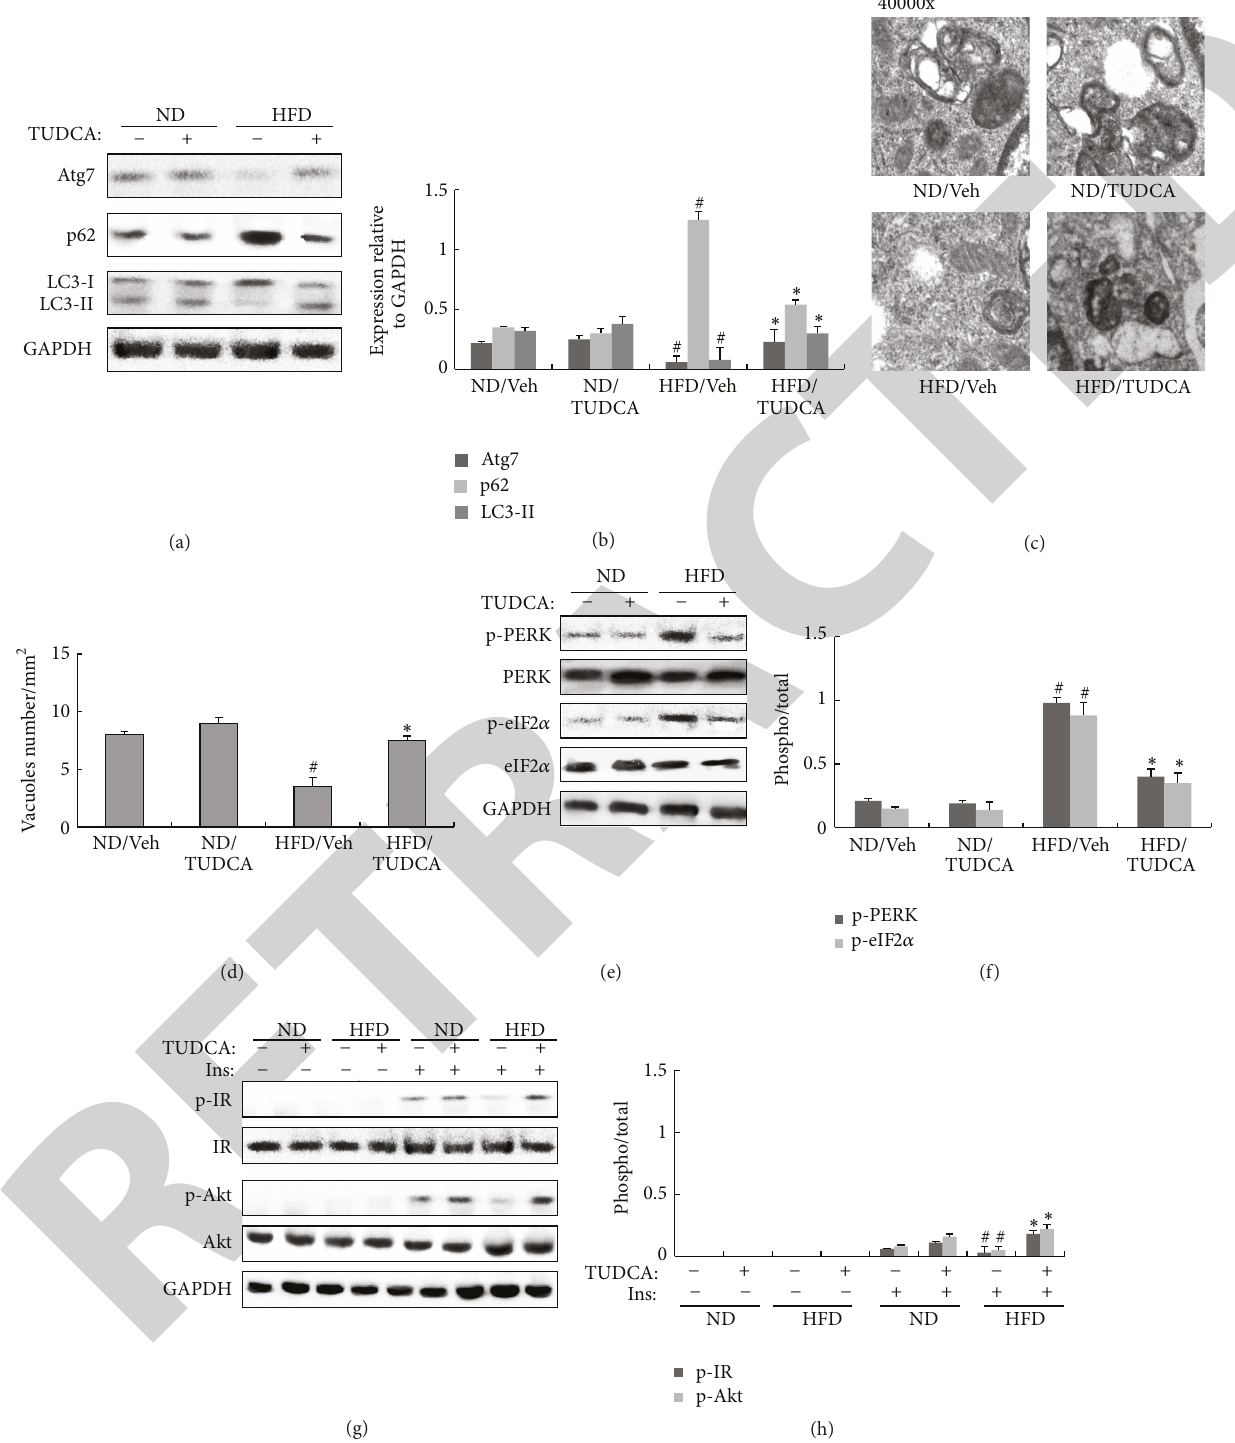
Figure 4: Effects of TUDCA on hepatic autophagic response, ER stress, and insulin signaling in the liver of obese mice. All analyses were performed in mice fed a normal diet (ND) or a high-fat diet (HFD) for 8 weeks and then injected daily with 500 mg/kg of TUDCA or with vehicle (Veh) for 8 weeks. (a) Protein expression of Atg7, p62, and LC3 in liver. (b) The relative protein quantity of Atg7, p62, and LC3 in liver. (c) Quantification of autophagolysosome-like vacuoles per field in the EM images of liver (magnification 40000x). (d) Quantification of autophagolysosome-like vacuoles per field in the EM images of liver. (e) Phosphorylation of PERK and eIF2 𝛼 in liver. (f) The relative protein quantity of p-PERK and p-eIF2 𝛼 in liver. (g) Phosphorylation of IR and Akt in liver. (h) The relative protein quantity of p-IR and p-Akt in liver. The relative quantity of proteins was analyzed using Quantity One software. A representative blot is shown and the data was expressed as mean ± SEM in each bar graph. ∗ 𝑃 < 0.05 (HFD/TUDCA versus HFD/Veh). # 𝑃 < 0.05 (HFD/Veh versus